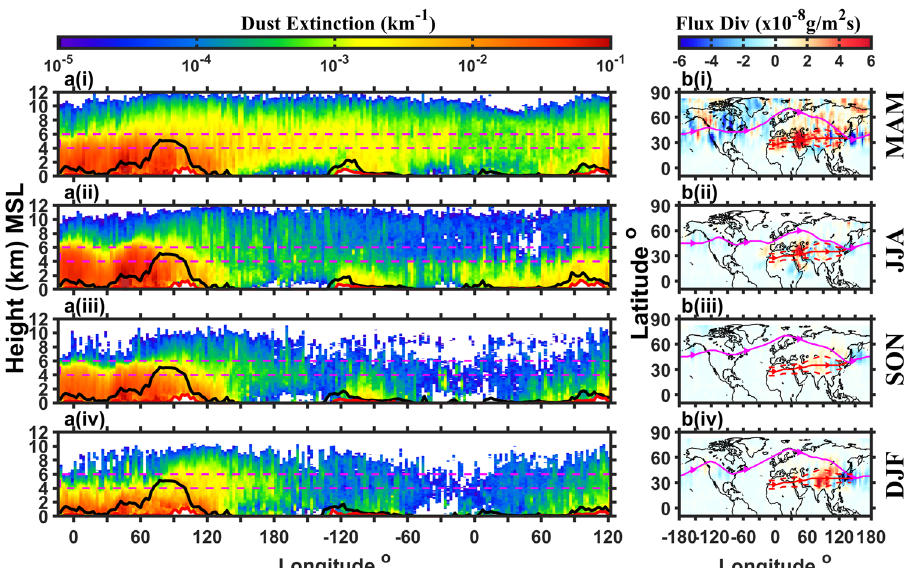
Fig. 4 Seasonal longitude-height cross sections of dust extinction and upper troposphere (above 6 km above mean sea level (MSL)) vertically integrated dust mass fl ux divergence ( fl ux div). a(i) – a(iv) Longitude-height cross sections of dust extinction along the selected global transport tracks. The dust extinction in a(i) – a(iv) is averaged between the red dashed lines (Fig. 4b(i) to b(iv)) from − 15° to about 135° longitudes and after that between ±5° latitude along the purple line. Black and red solid lines in a(i) – a(iv) indicate the maximum and minimum terrain heights between the average latitudes along the track. The pink dashed lines indicate 4 and 6 km MSL height respectively. b(i) – b(iv) Upper troposphere vertically integrated dust mass fl ux divergence calculated from CALIOP observations and MERRA-2 reanalysis, red color indicates divergence and upward transport, blue color indicates convergence and downward transport. The red and purple lines are dust transport tracks (same as in Fig. 1 and Fig. 2), with small triangles indicating the transport direction. From top to bottom are four seasons March – April – May (MAM), June – July – August (JJA), September – October – November (SON) and December – January – February (DJF),